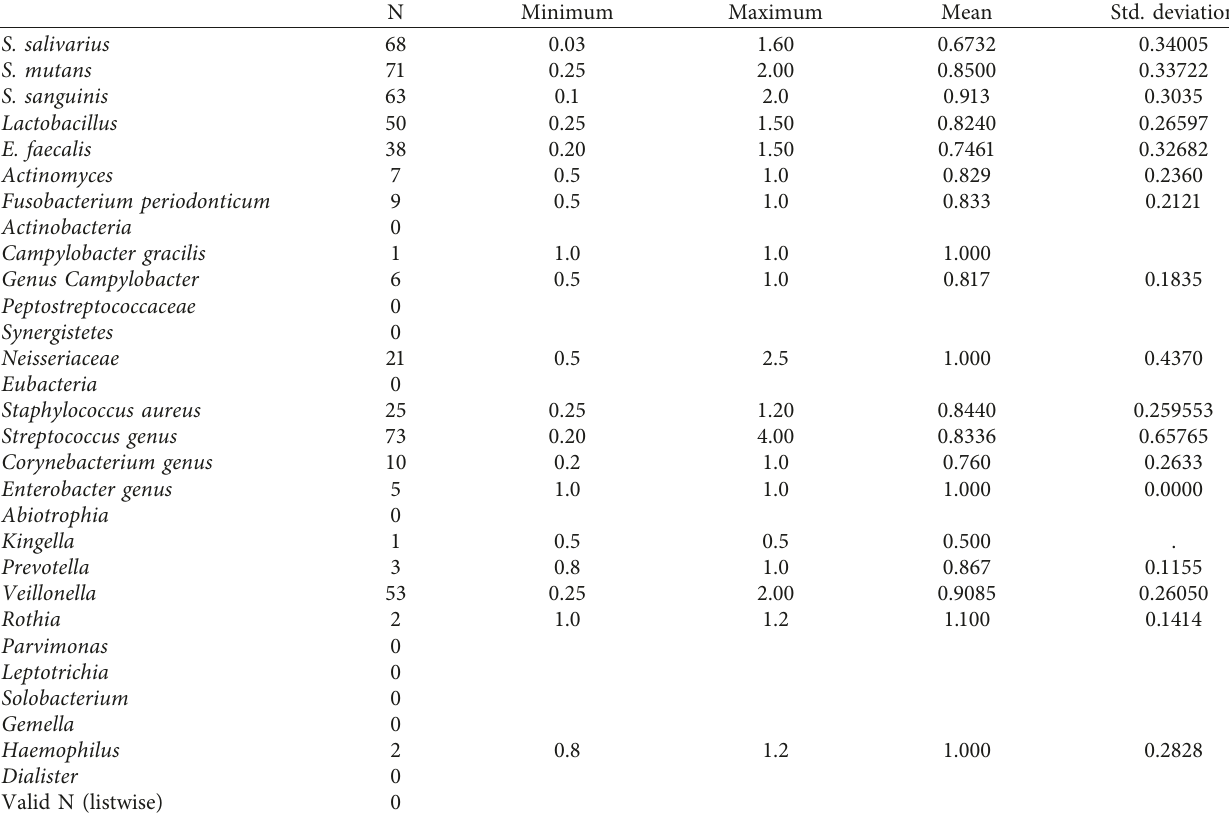
Table 5: The descriptive data regarding the proportion of bacteria in dental plaque/tongue plaque.